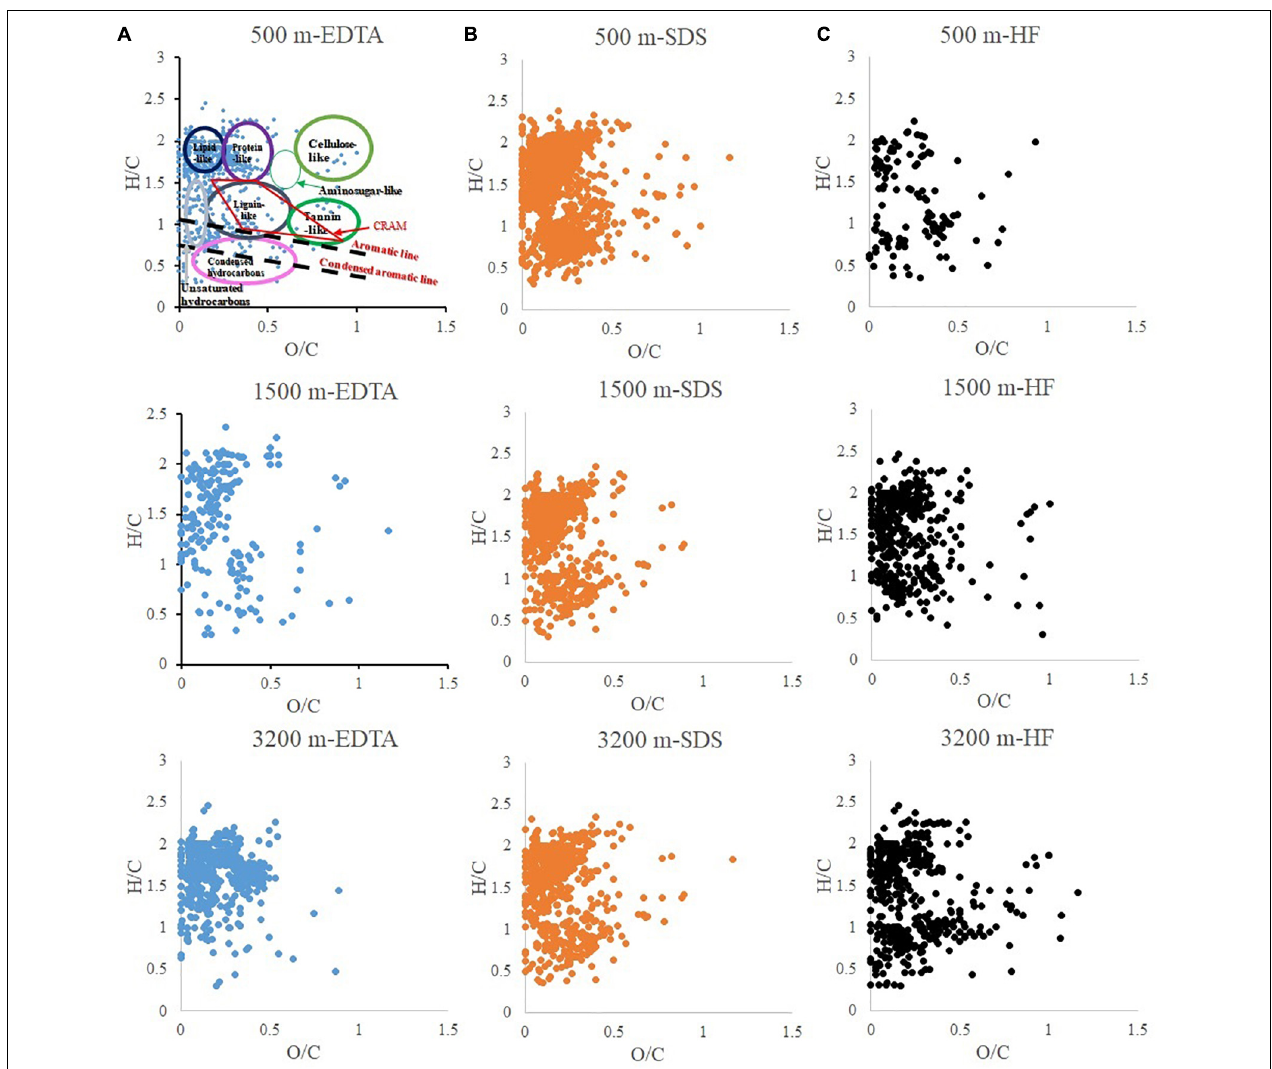
FIGURE 4 | van-Krevelen diagram of particulate organic matter extracted by different reagents: (A) EDTA (ethylenediaminetetraacetic acid disodium salt dihydrate); (B) SDS (sodium dodecyl sulfate); (C) HF (hydrofluoric